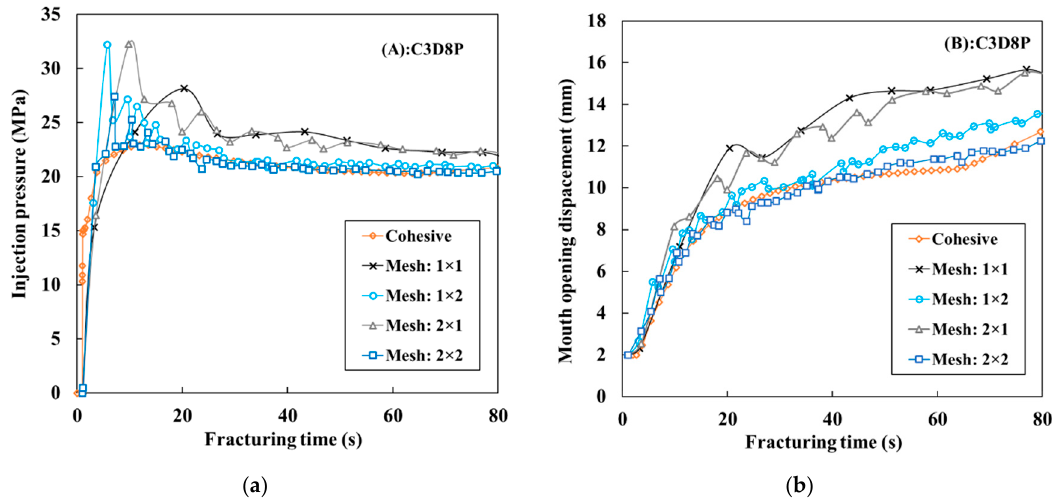
Figure 5. Variation of injection pressure and mouth opening displacement with C3D8P: ( a ) Variation of injection pressure; ( b ) Variation of mouth opening displacement.